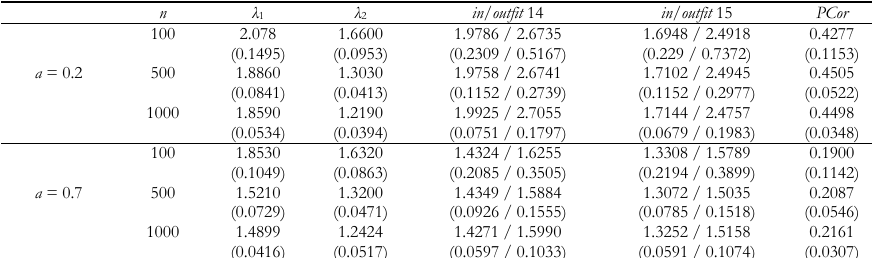
Mean value, calculated on 100 simulated data sets, of the first two eigenvalues, the infit and outfit mean square statistics of items 14 and 15 and the Pearson correlation for the couple 14-15; in parenthsis the standard errors n λ 1 λ 2 in/outfit 14 in/outfit